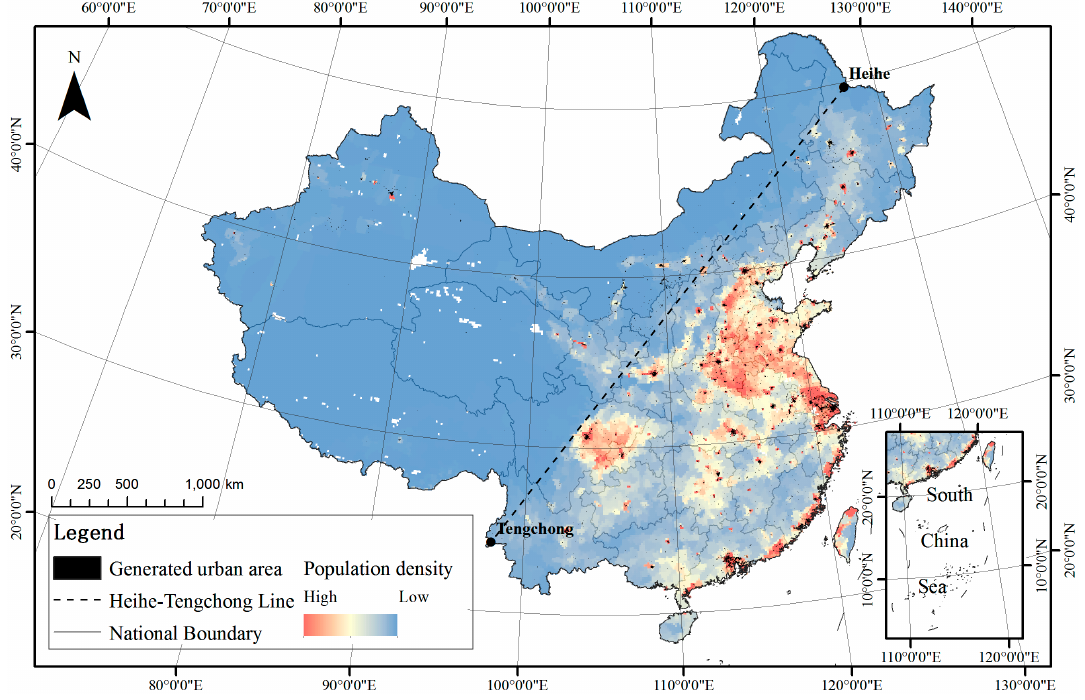
Figure 4. Urban map obtained using the proposed classification scheme. Table 2. Error matrices and accuracy assessment for urban and non-urban land cover types.